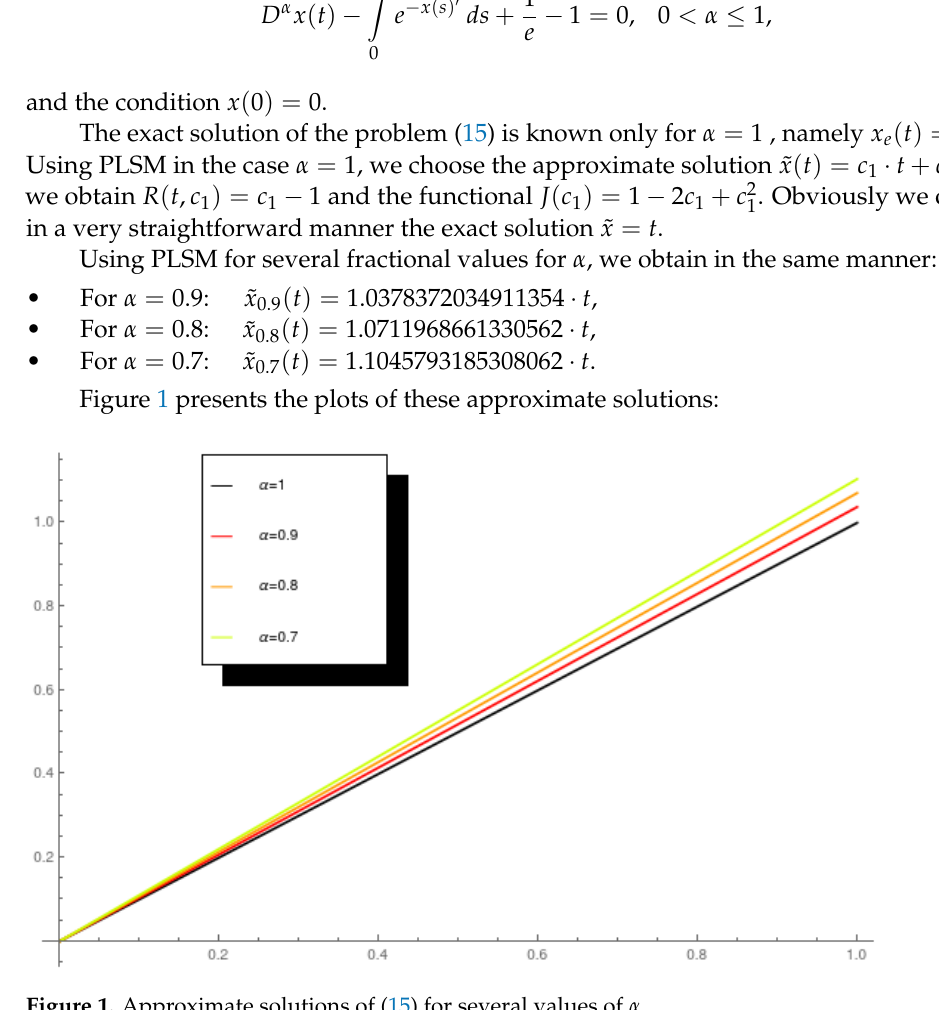
Figure 1. Approximate solutions of (15) for several values of α